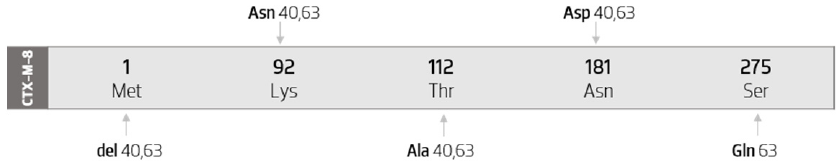
Figure 6. Diagram of the mutations of CTX-M-8 cluster’s members, compared with the CTX-M-8 sequence. Scheme based on available sequences and phenotype in the Bacterial Antimicrobial Resistance Reference Gene Database.